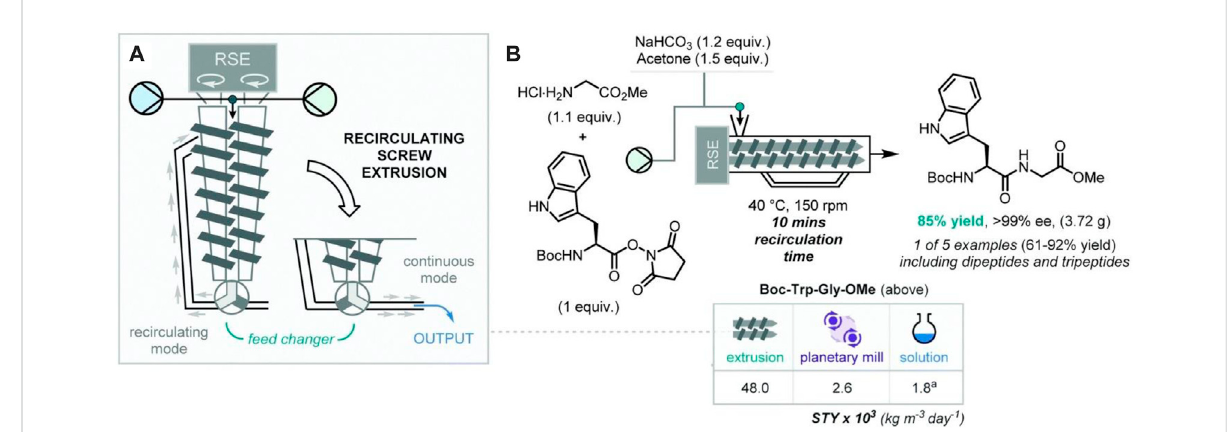
FIGURE 3 Bulk solvent and CRM-free peptide coupling enabled by recirculating screw extrusion; (A) experimental set-up, (B) chemical synthesis. Reproduced from (Bolt et al., 2022) with permission from the Royal Society of